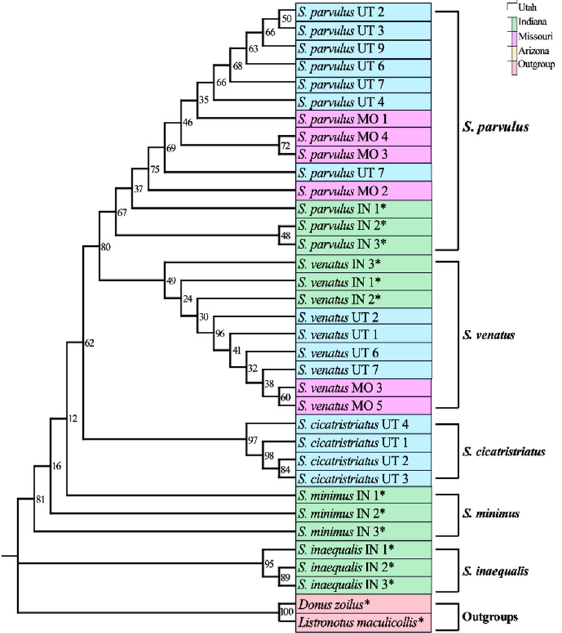
Figure 2. Maximum likelihood tree of ITS2 sequences from Sphenophorus parvulus, S. venatus , S. minimus , S. inaequalis , and S. cicatristriatus . Collection location is represented by color blocks; Utah (blue), Indiana (green), Missouri (purple), Arizona (yellow), outgroups (red). Replicate numbers are indicated to the right of the scientific name and collection state (Utah = UT, Indiana = IN, Missouri = MO, Arizona-AZ). Numbers at nodes are bootstraps values (1000 bootstrap replicates as percentages). * indicates sequences obtained from [17].